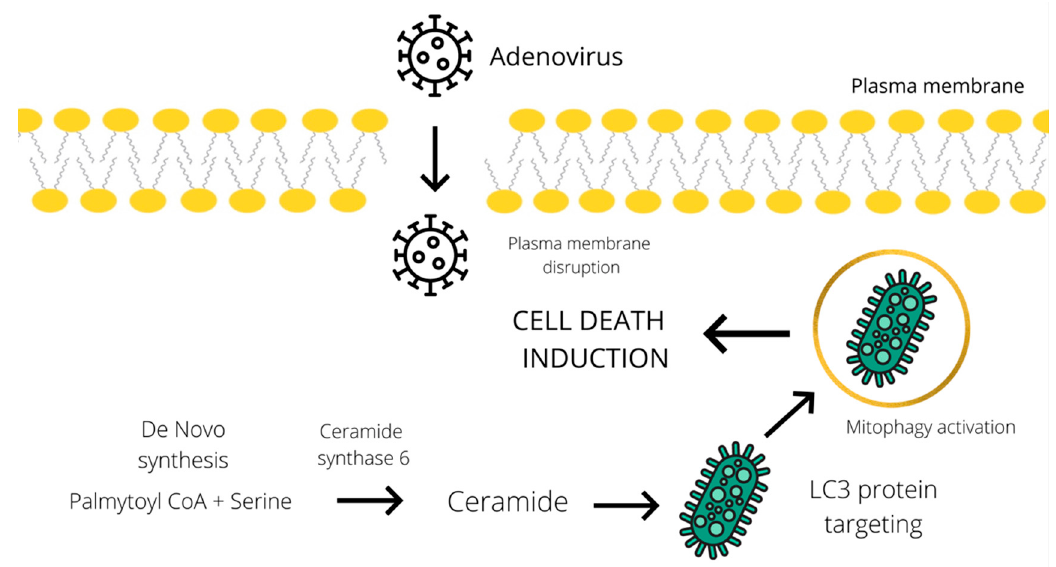
Figure 1. Schematic representation of the tentative cell death mechanism operating through a ceramide-mediated mitophagy. Adenoviral infection induces ceramide accumulation through de novo synthesis from palmitoyl CoA and serine [19]. Subsequently, ceramide mediates the LC3 binding to the mitochondrial membrane and promotes lethal mitophagy leading to autophagic cell death [25].